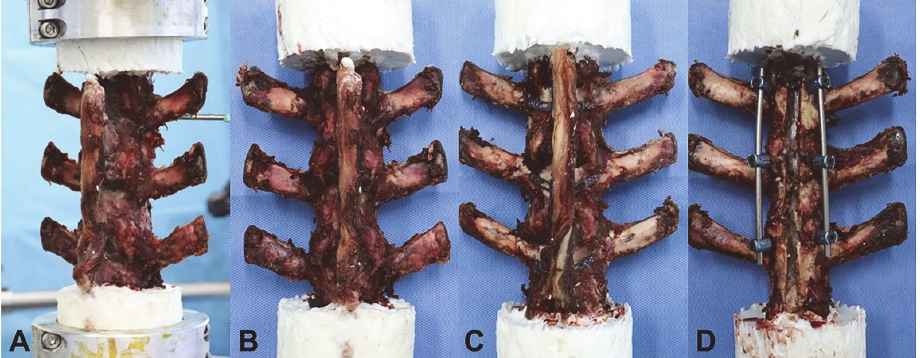
Figure 2. The mechanical testing machine and specimens for biomechanical experiments. ( A ) Normal lumbar spine specimens were fixed on a 6-degrees-of-freedom mechanical testing machine; ( B ) control group—normal specimens; ( C ) laminoplasty group—L2, L3 and L4 laminoplasty with microplate fixation; and ( D ) laminectomy group—L2, L3 and L4 laminectomy with pedicle screw fixation.